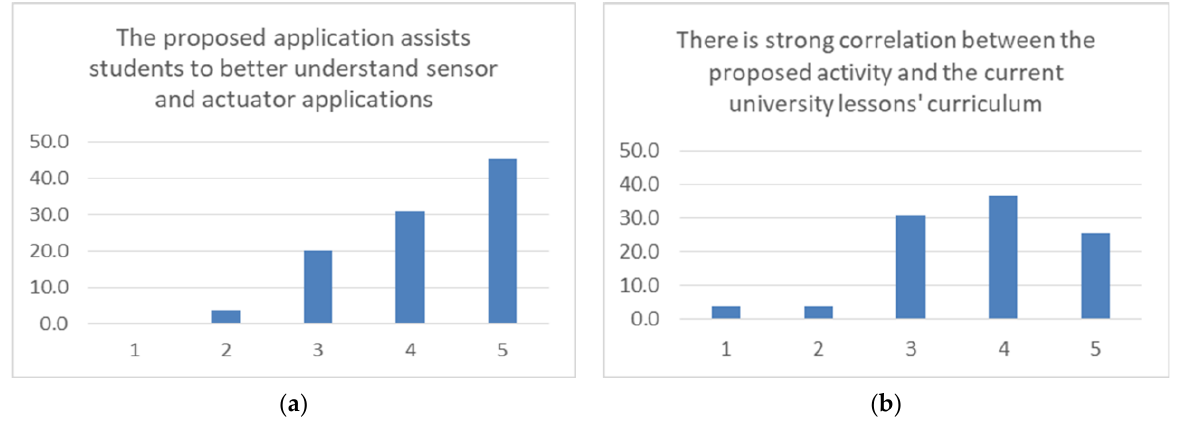
Figure 16. Participants’ opinions about: ( a ) the contribution of the proposed activity to understand the role of sensors and actuators in applications; ( b ) the correlation of the proposed activity with the current university lessons’ curriculum.